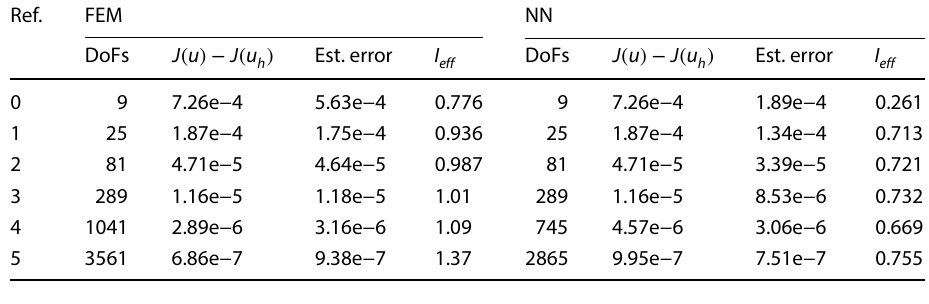
Fig. 3 Section 5.1.3: Grid refinement with mean squared value goal